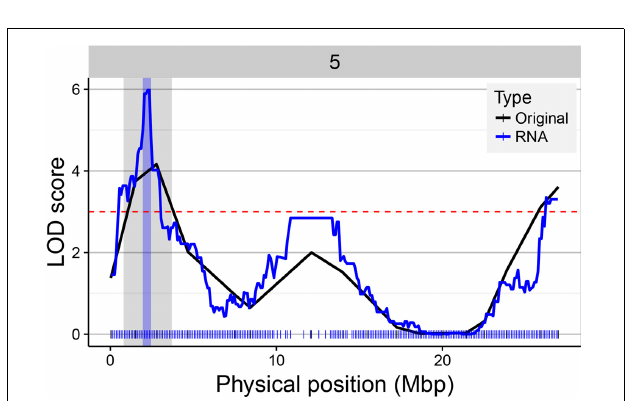
FIGURE 9 | Gain in QTL mapping precision using the RNA-seq map. The figure illustrates the differences in LOD score and CI of the QTL for the trait “Size_circ_D_mei.10” located on the top of chromosome 5 using the original (black line) and the RNA-seq map (blue line). The physical position of the markers in the original and RNA-seq map is represented on the x -axis with black (17) and blue (243) tick marks, respectively. The QTL significance threshold is indicated by a horizontal dashed red line. The gray and blue vertical bars in the region of the QTL of interest indicate the CI of the QTL in the original and RNA-seq map,